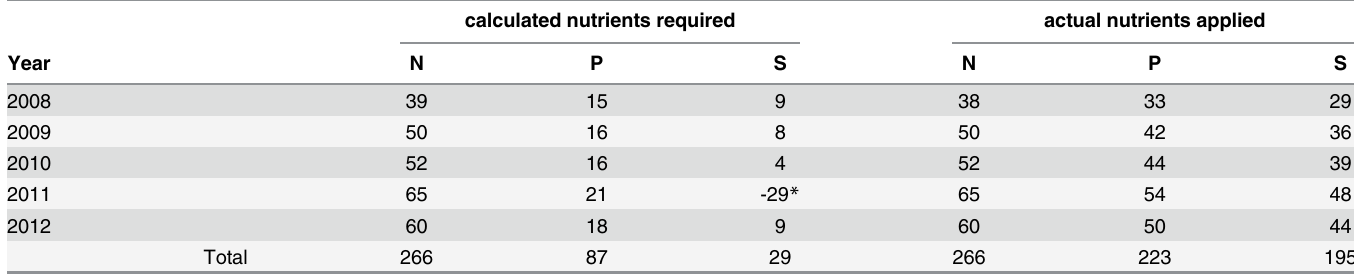
* 2011 stubble was canola which had S in excess to that required to humify 30% of the stubble-C but this was not taken into account when calculating 2011 nutrients required for stubble-C humi fi